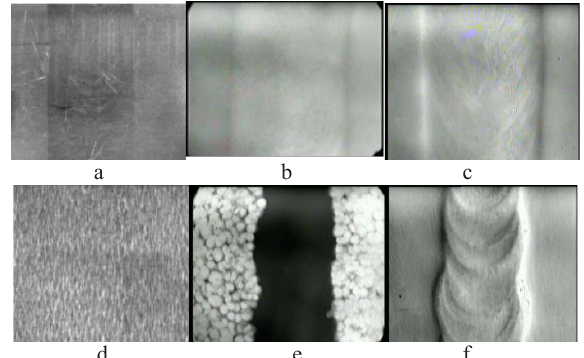
Fig. 1. Optical (a, d) and magneto-optical (b, c, e, f) images of welds: aluminum (a-c), stainless steel (d-f); orthogonal (b, e) and longitudinal (c, f) excitation of eddy